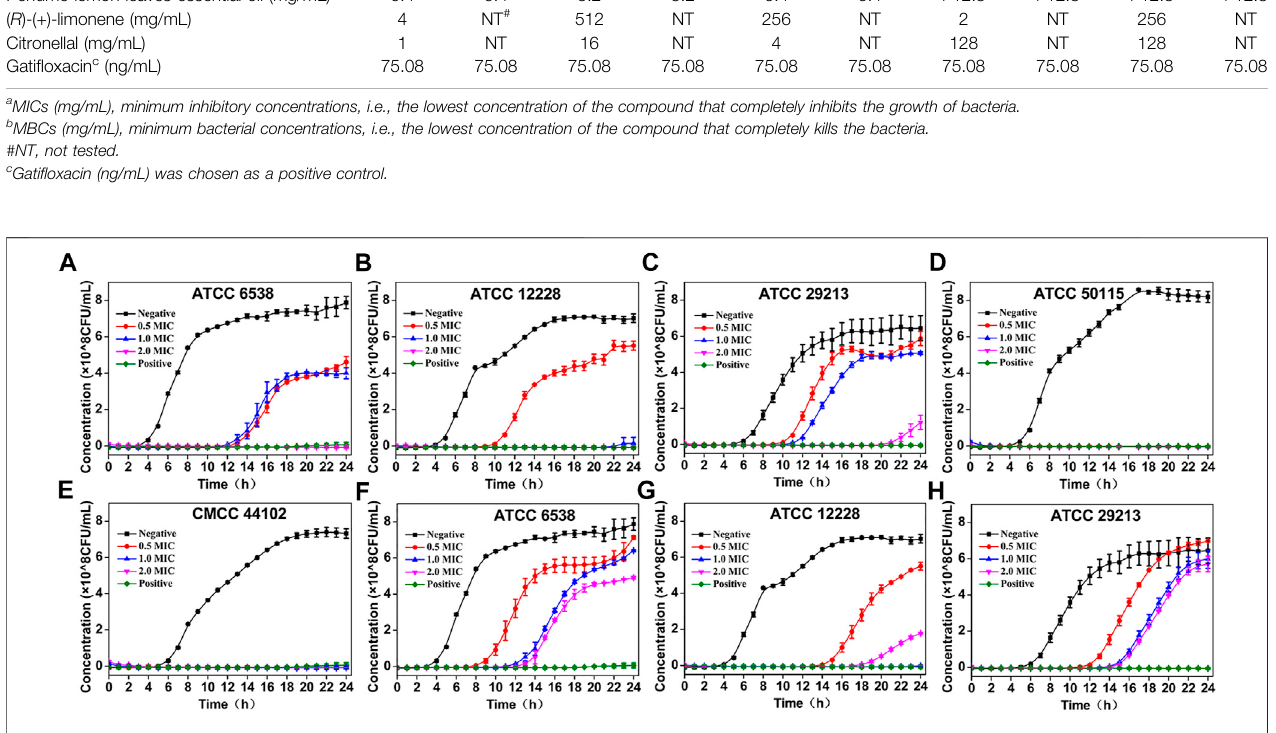
FIGURE 4 | The time killing kinetic studies of the oil extracted from discarded perfume lemon and leaves against fi ve bacteria strains. Including Staphylococcus aureus (ATCC 6538) (A,F) , Staphylococcus epidermidis (ATCC 12228) (B,G) , Staphylococcus aureus subsp. Aureus (ATCC 29213) (C,H) , Salmonella typhimurium (CMCC 50115) (D) , Escherichia coli (CMCC 44102) (E) and exposed to four different concentrations of the oil extracted from discarded perfume lemon ( Figures 3A – E ) and theoil extracted from discarded perfume leaves ( Figures3F – H ) accordingto theirrespective MICs( n (cid:2) 4), gati fl oxacin was also conducted aspositivecontrol along with the two tested essential